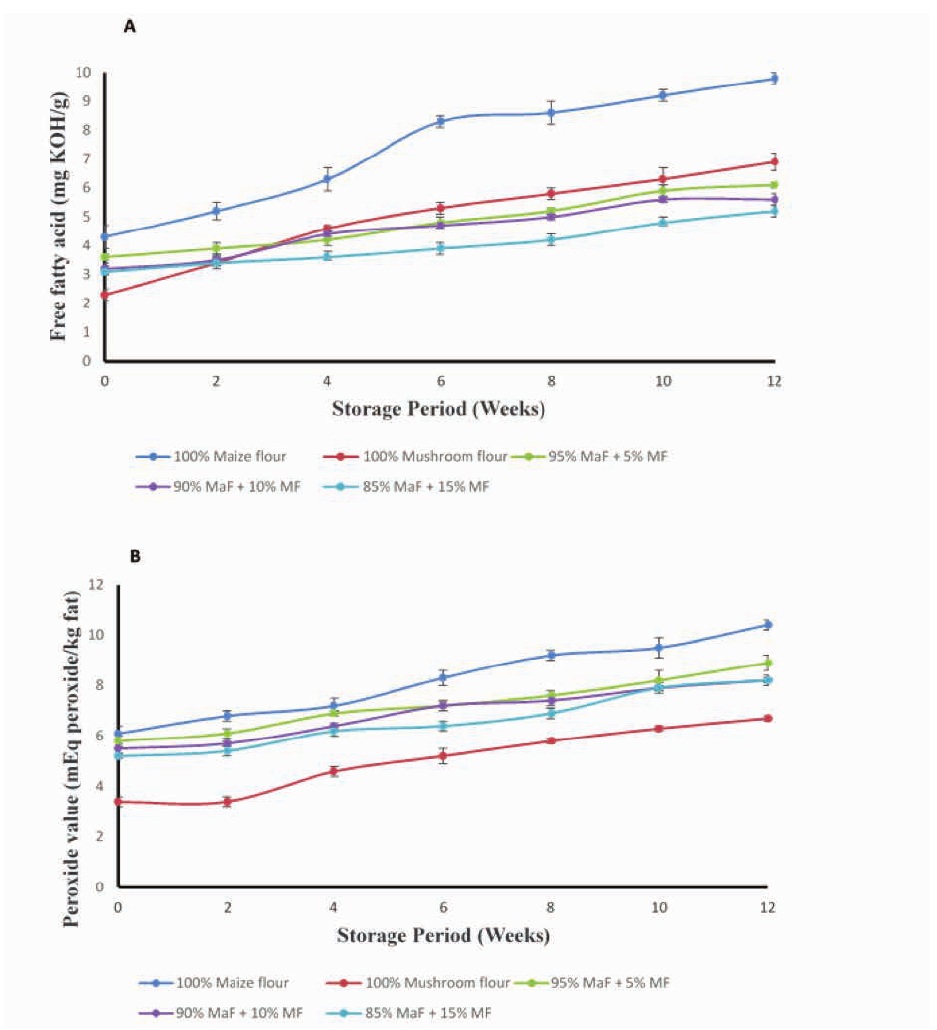
Figure 1: Free fatty acid of stored maize flour blends with mushroom flour and their control (A)Peroxide value of stored maize flour blends with mushroom flour and their control (B) Keys: Controls are 100% maize flour and 100% mushroom flour; MaF is maize flour; MF is mushroom